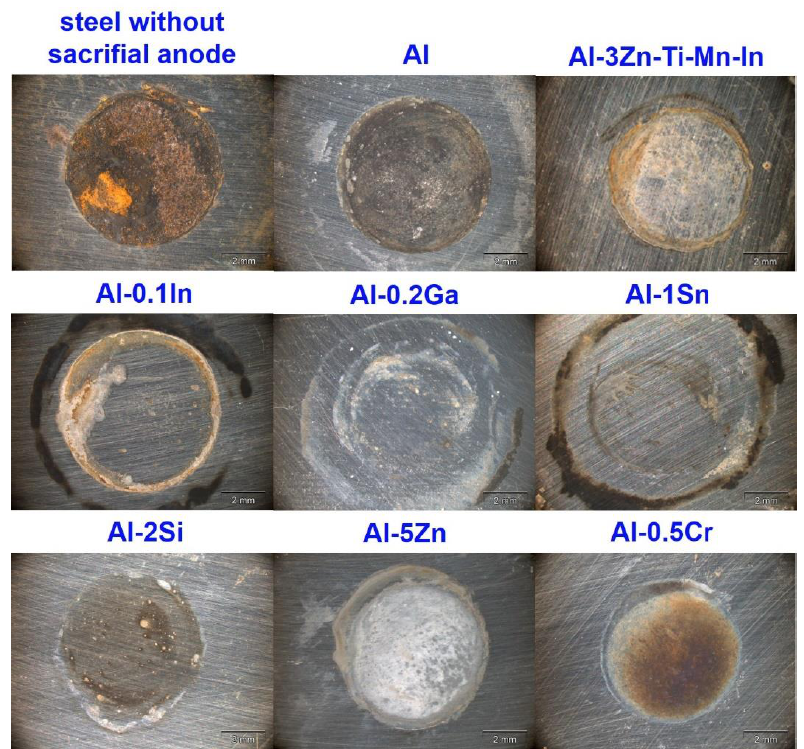
Figure 12. Optical images showing the protective effect for the steel sheet using the different sacrificial anodes after 21 days ’ galvanic coupling.